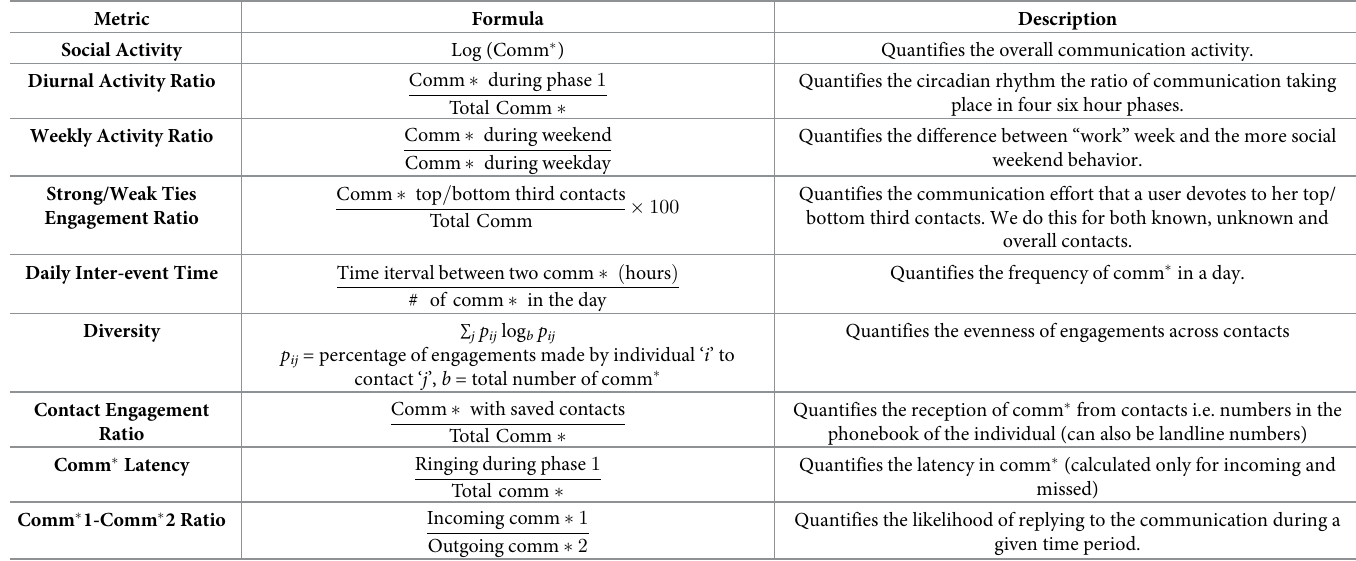
Table 5. Call/Call duration data based features.